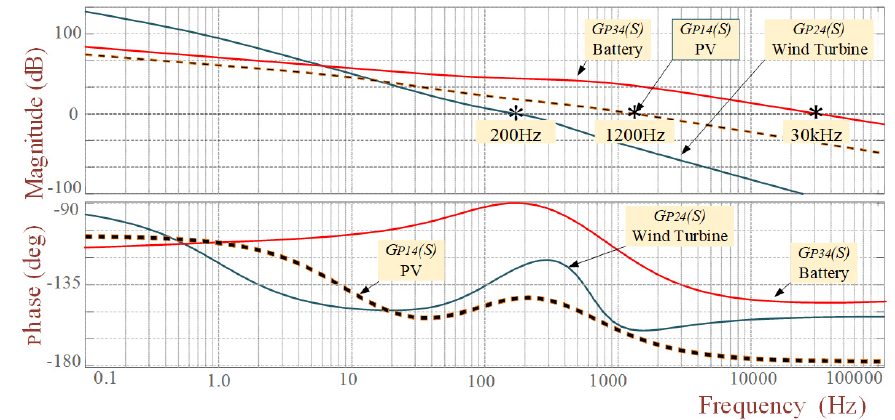
Figure 5. The magnitude and phase Bode diagrams of the power control closed loop transfer functions.